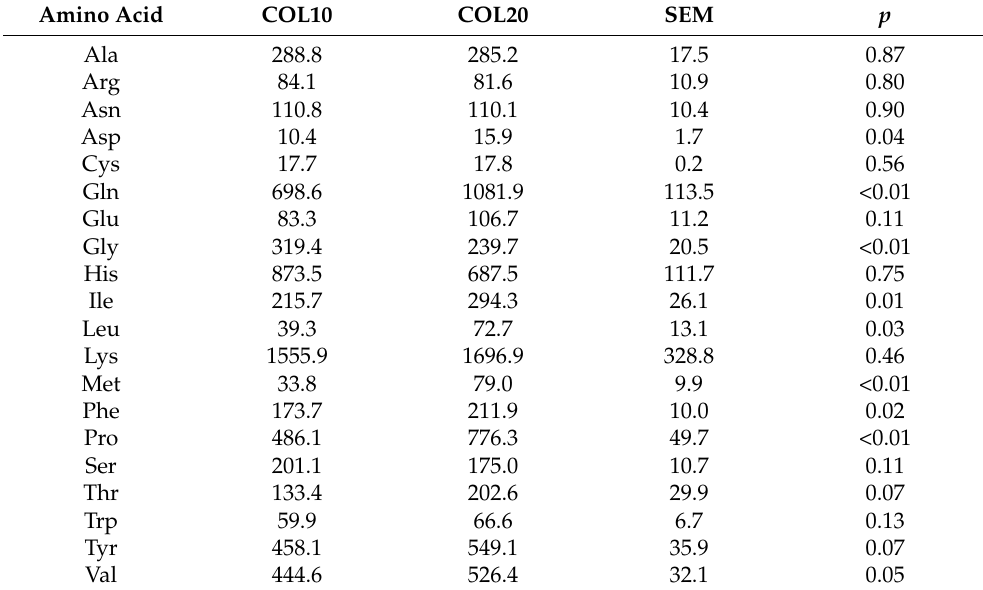
Table 3. Amino acid plasma concentration (ng/mL) in neonatal piglets fed 10% (COL10, n = 8) or 20% (COL20, n = 8) of birth weight of colostrum over the first 24 h after